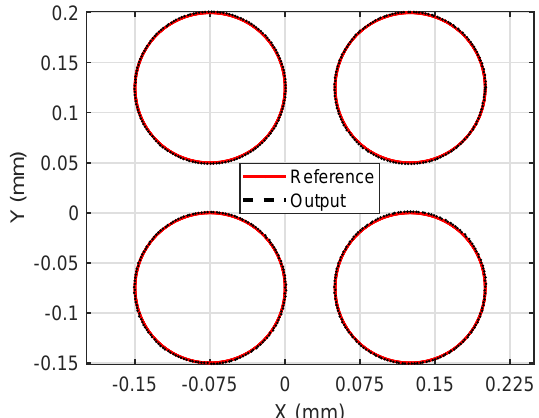
Figure 12. Tracking results of the experiment.